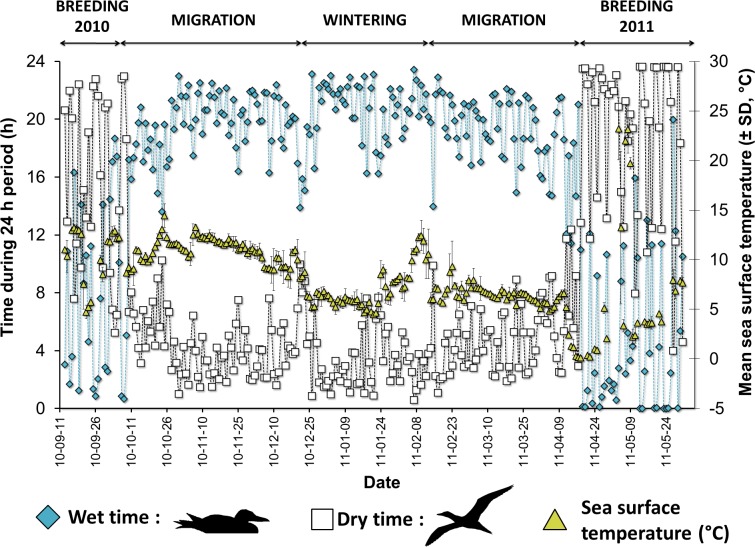
Example of long-term monitoring of daily activity patterns and temperature recorded using a combined Global Location Sensor (GLS), immersion and temperature logger attached for 260 days on a Northern Gannet nesting on Bonaventure Island and wintering off the northeast coast of the U.S. Diamonds (◆) depict the wet time (h), when the gannet is diving or sitting on the water; squares (□) depict the dry time (h), when the gannet is out of the water, flying or on land at the colony; and, triangles (Δ) are the mean sea surface temperature per day (± SD,°C).Breeding periods are bounded by dry time per day of more than 12 h, and the date of arrival at the wintering area is based on geolocation using the light data (see Methods).